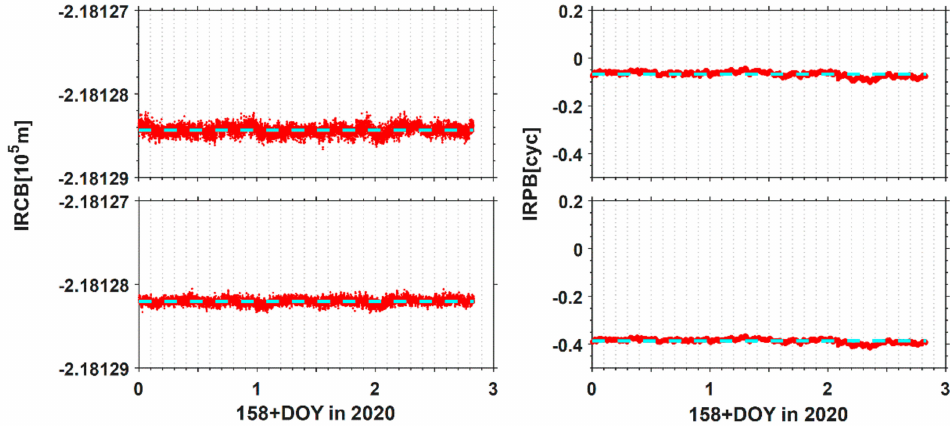
Figure 6. The estimation results of IRCB and IRPB under common clock mode. Each row corresponds to B1 and B2 frequency from top to bottom, and the blue-green dotted line is the corresponding mean of